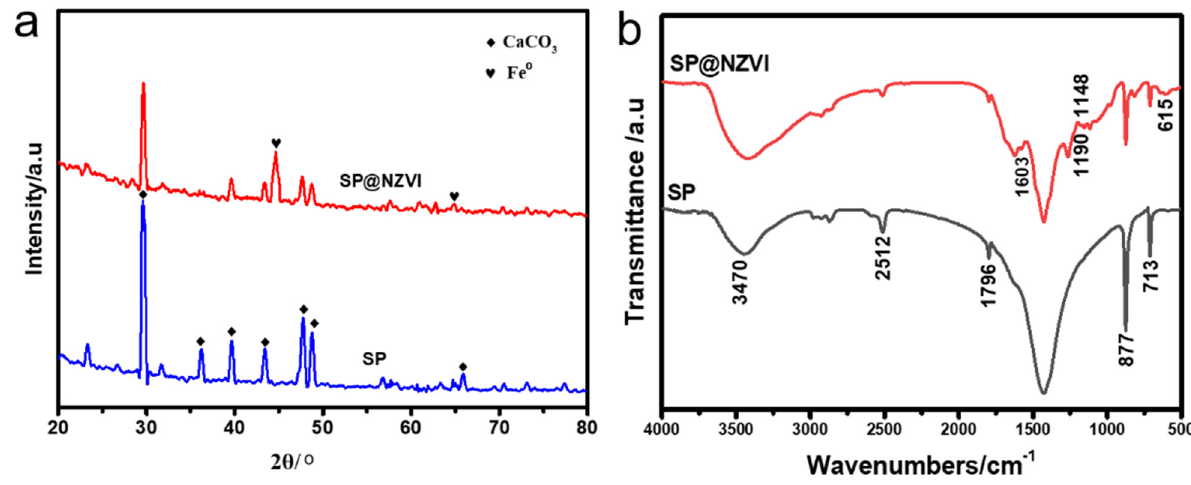
Figure 3. Characterization of SP and SP@nZVI: ( a ) XRD ( b ) FT − IR.